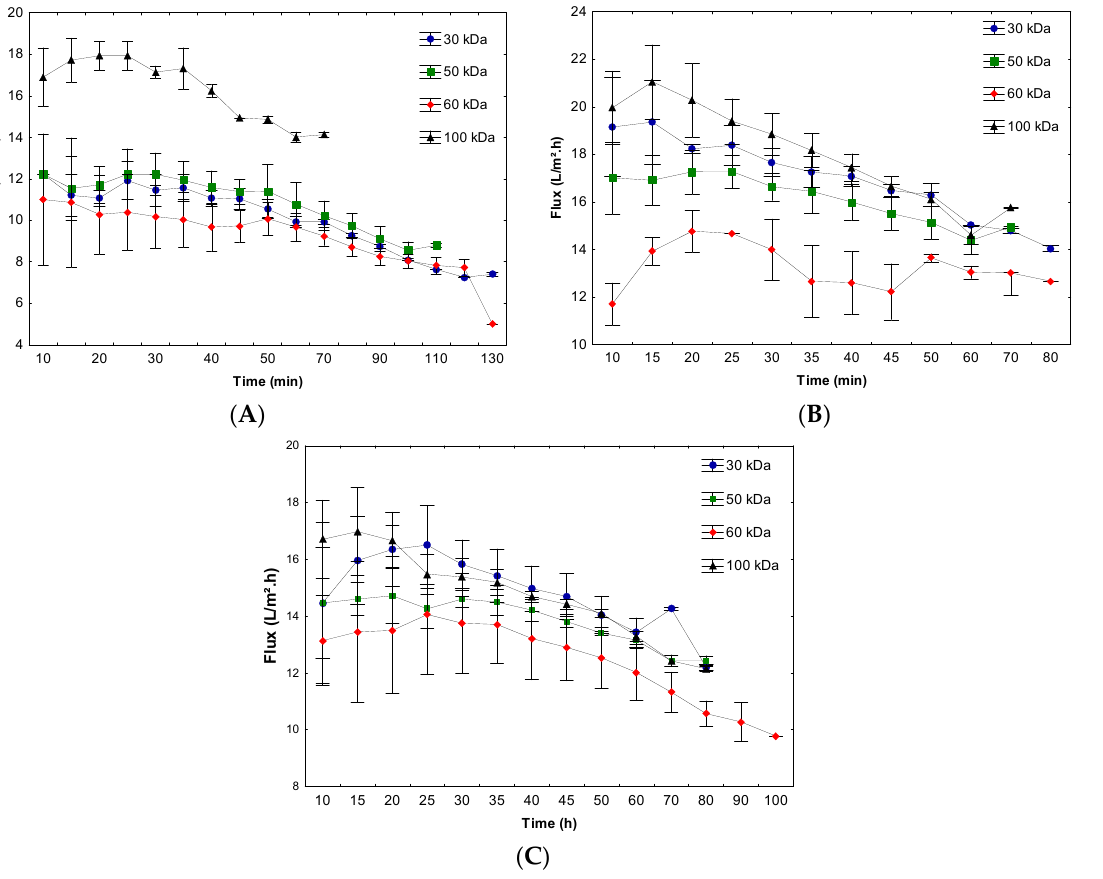
Figure 2. Permeate flux during ultrafiltration at pH 6.5 ( A ), 7.0 ( B ), and 7.5 ( C ).